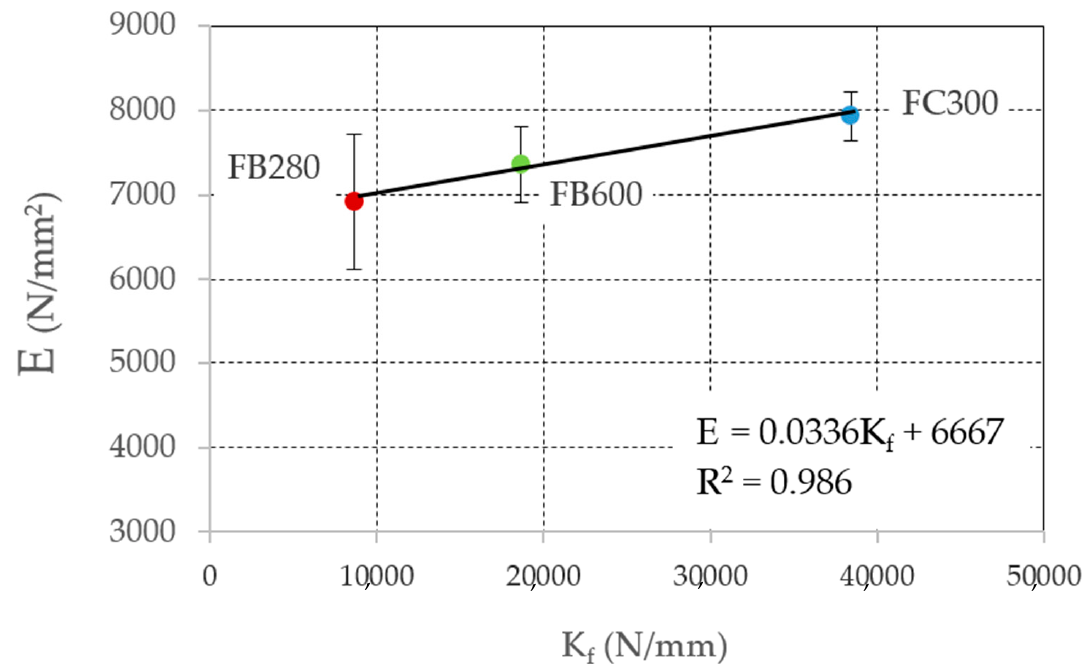
Figure 7. Relationship between the modulus of elasticity of the reinforced test pieces and the rigidity of the reinforcements.